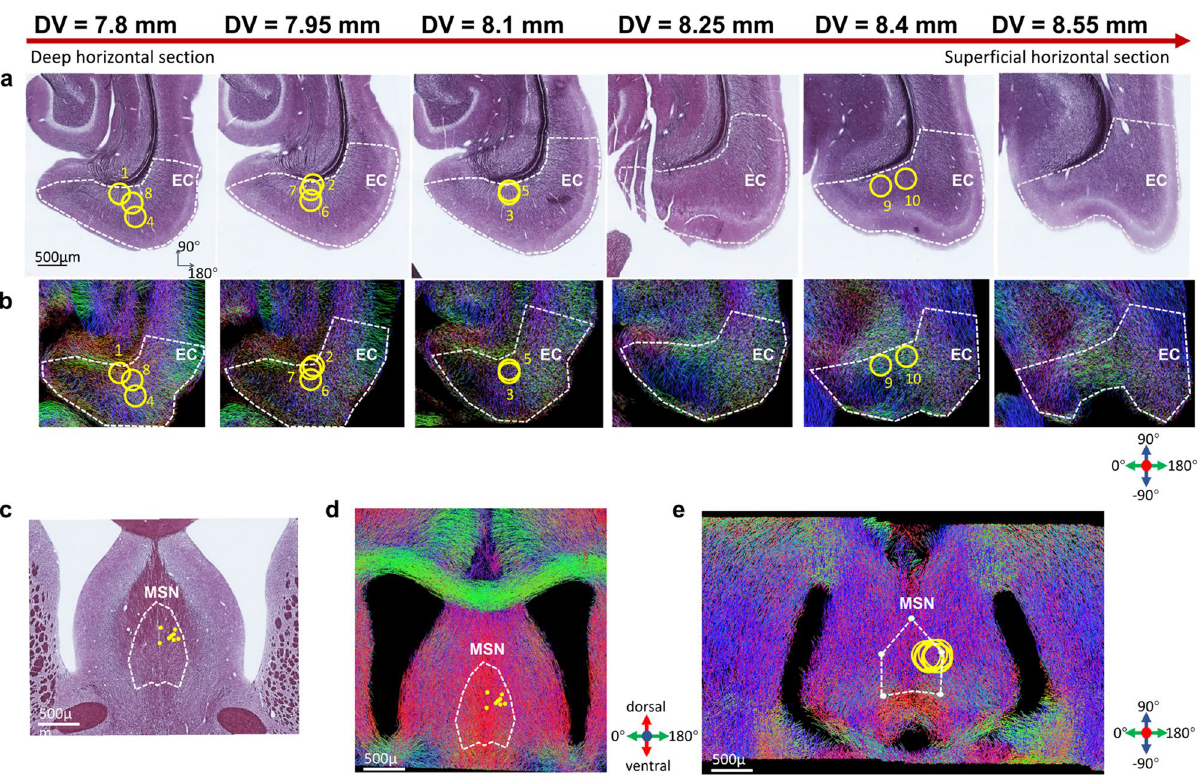
Figure 6. Histology and diffusion MRI tractography evaluations of EC and MSN. ( a ) Myelin staining of EC in anatomical horizontal sections corresponding to axial view in MRI. Estimated DV coordinates are displayed on top of each section. Red arrow indicates ordering from deeper to more superficial horizontal sections. ( b ) Direction-encoded color tractograms which correspond to the sections shown in a. The yellow circles indicate the location and extent of the 3-channel electrode implanted in each animal, indicated by different numbers. ( c ) Myelin staining of the MSN in coronal view; ( d ) corresponding filtered direction-encoded color tractogram in coronal view; and ( e ) tractogram in axial view. The yellow points in ( c ) and ( d ), and the circles in ( e ), indicate the center of the tips in coronal view, and the extent of the implanted electrodes in axial view, respectively. Color coding: red, dorsoventral; blue, rostrocaudal; green